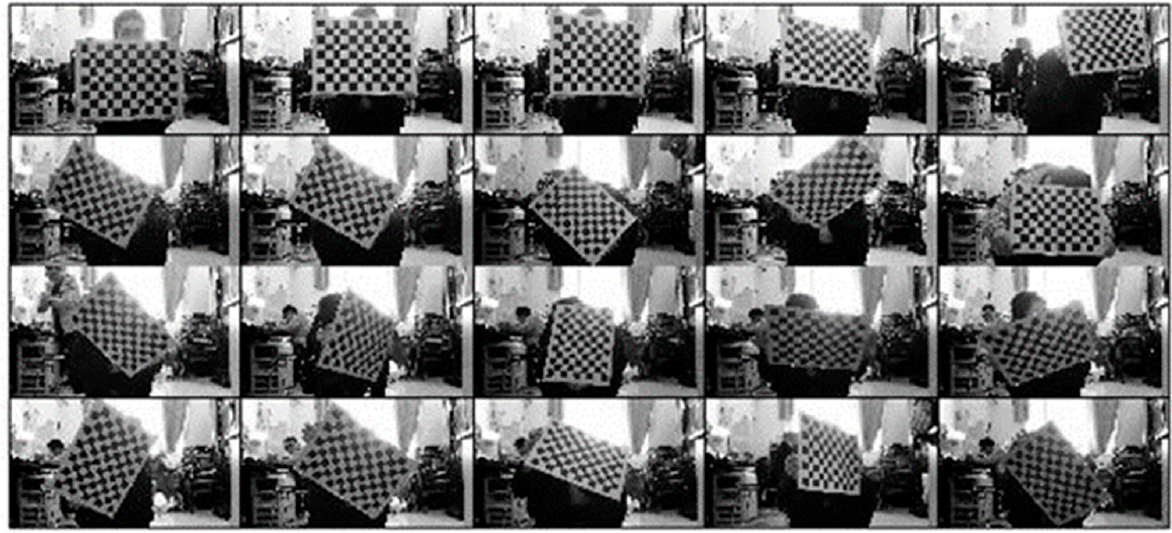
Figure 10. Checkerboard diagram from different perspectives.